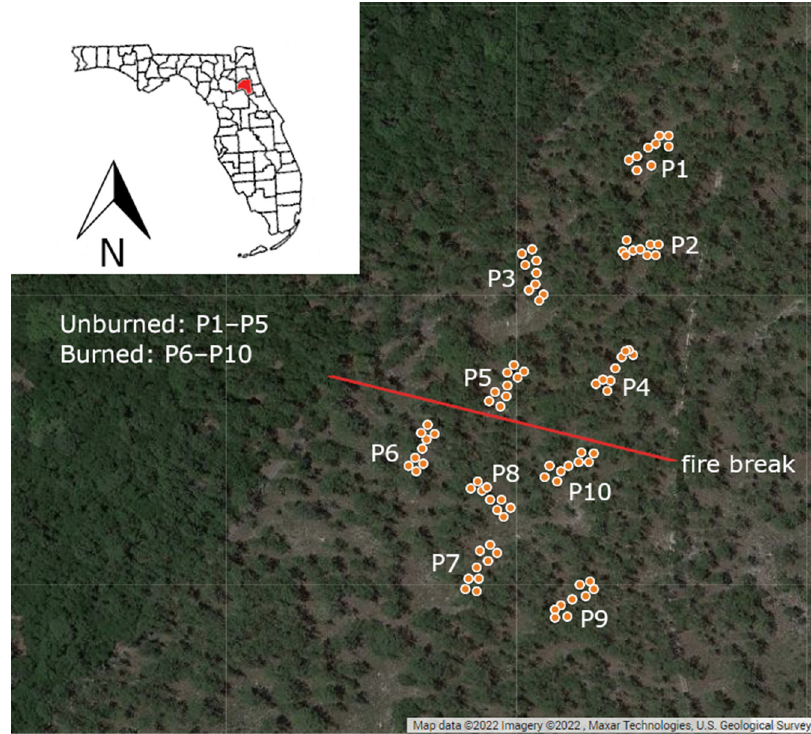
Figure 1. Diagram of the 10 treatment plots, each containing a pair of treatment subplots, at Ordway- Swisher Biological Station in Putnam Co. FL. Red line represents the division between burned and unburned sites. One experimental burn was conducted south of the red line; north of the line remained unburned. Each 25 m 2 subplot is represented by four orange circles, each represents the Global Positioning System referenced locations of a subplot corner.